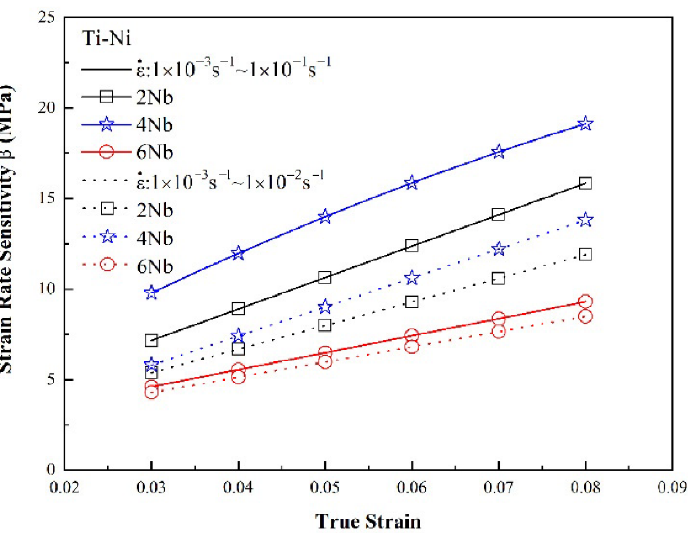
Figure 8. Strain rate sensitivity as a function of true strain under static deformation conditions.